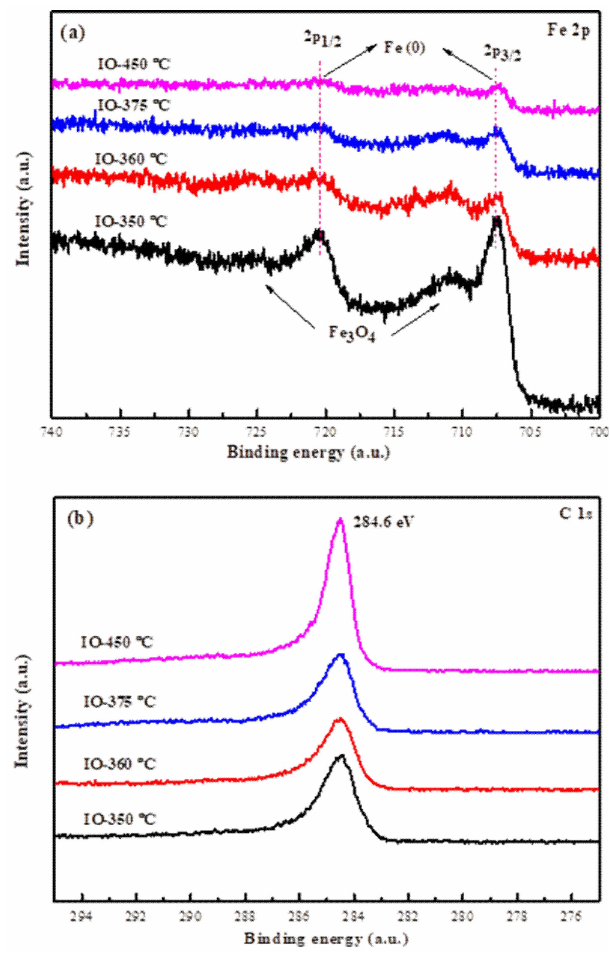
Figure 2. XPS spectrum of the fresh IO-t ◦ C catalysts: ( a ) Fe 2p, ( b ) C 1s.